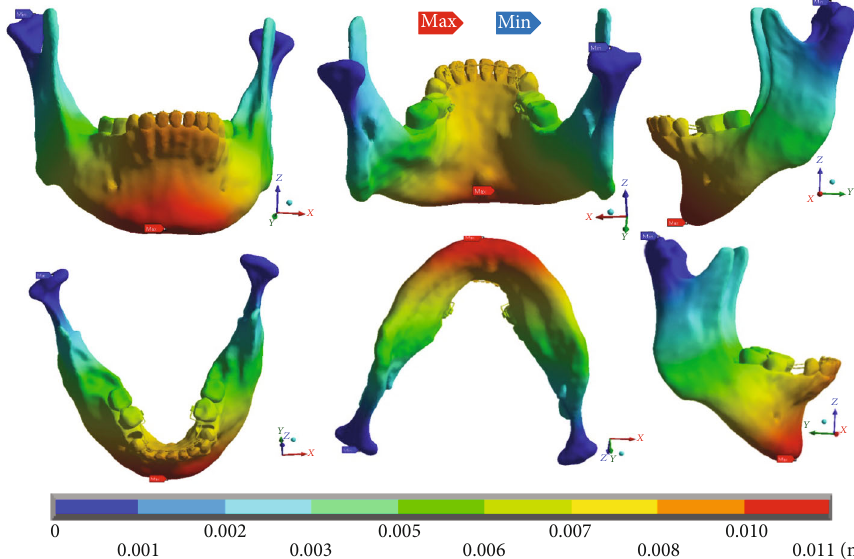
Figure 10: Total deformation occurring in the complete system (mandibular bone, dental organs, brackets, and wires). The red marker indicates the maximum deformations, and the blue marker indicates the minor